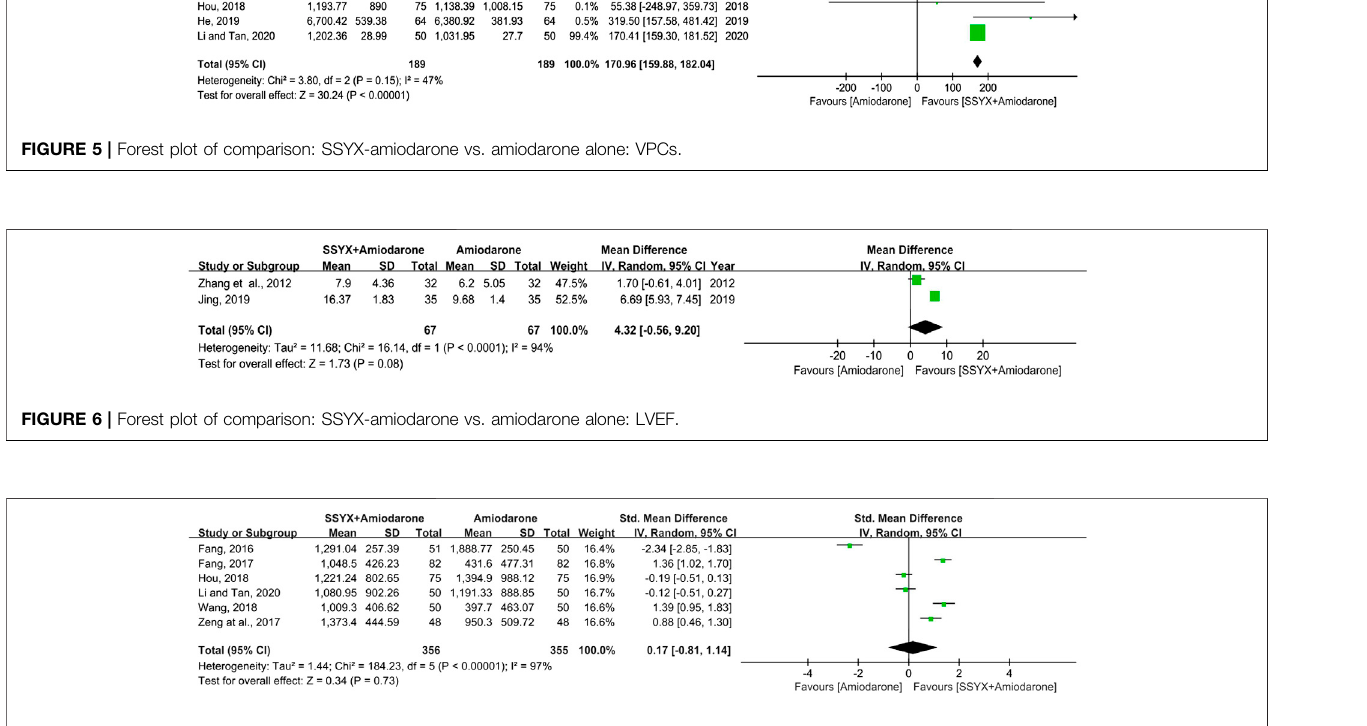
FIGURE 7 | Forest plot of comparison: SSYX-amiodarone vs. amiodarone alone: NT-proBNP.